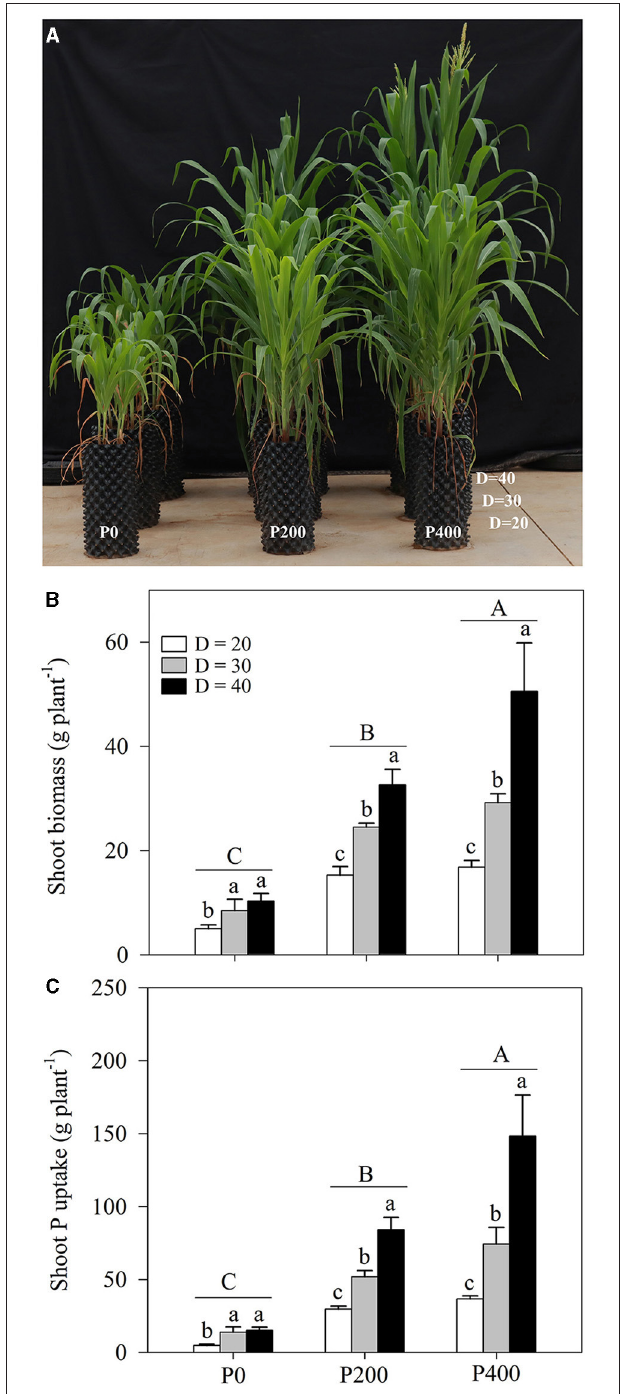
FIGURE 1 | Plant growth performance (A) , shoot biomass (B) , and shoot phosphorous (P) content (C) , under different P supply gradients and space availability conditions. Each value represents the mean of four replicates ( + SD). Different lower-case letters indicate a significant difference among different space availability levels, and different capital letters indicate a significant among different P levels. P0, 0mg P kg − 1 soil; P200, 200mg P kg − 1 soil; and P400, 400mg P kg − 1 soil; D = 20, D = 30, and D = 40 represent diameter of pot is 20, 30, and 40cm, respectively.